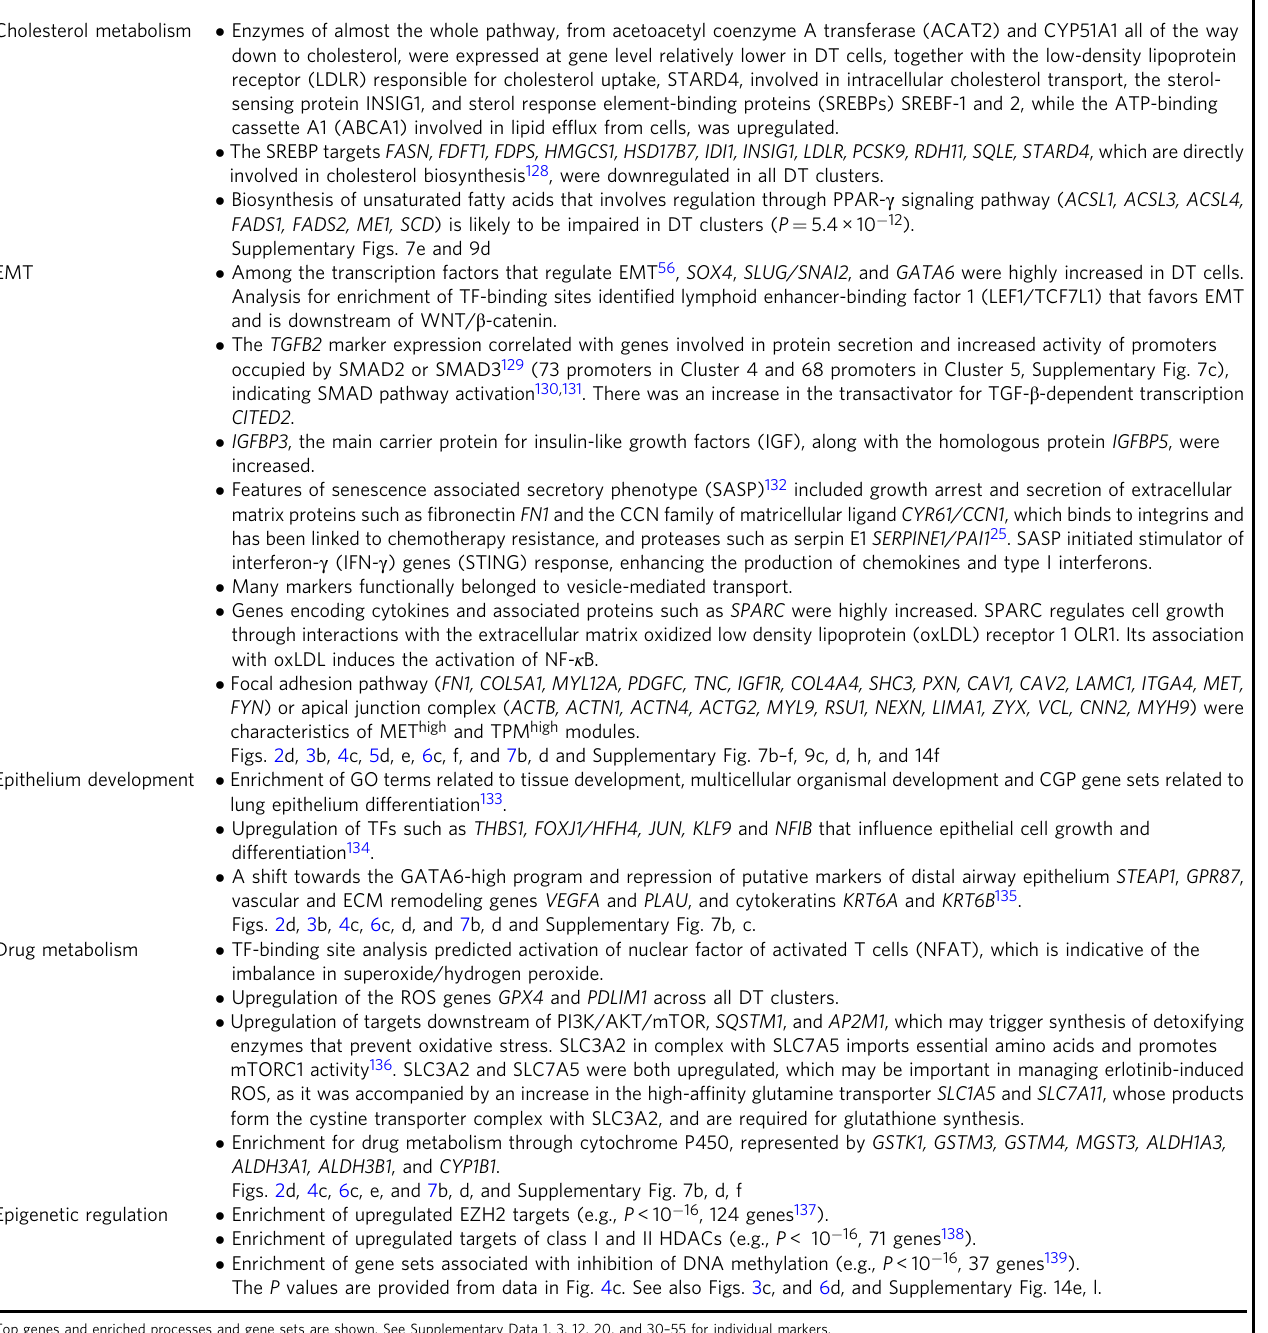
independent clusters but represented a fraction of Erl DT clusters. This suggested that combined treatment did not generate a signi fi cantly differential transcriptional response that would result in novel surviving cell subpopulations. In fact, Criz-T markers signi fi cantly overlapped with terms from MSigDB Collections which were identi fi ed above for erlotinib DT markers, including the EGFR-TKI resistance signature 33 (Fig. 6c, d, e.g., ALDH1A3 and TACSTD2 in Supplementary Fig. 13e) and were highly expressed in erlotinib DTP states (Supplementary Fig. 13g). We were able to detect upregulation of markers that distinguish Criz-T clusters from Criz-S